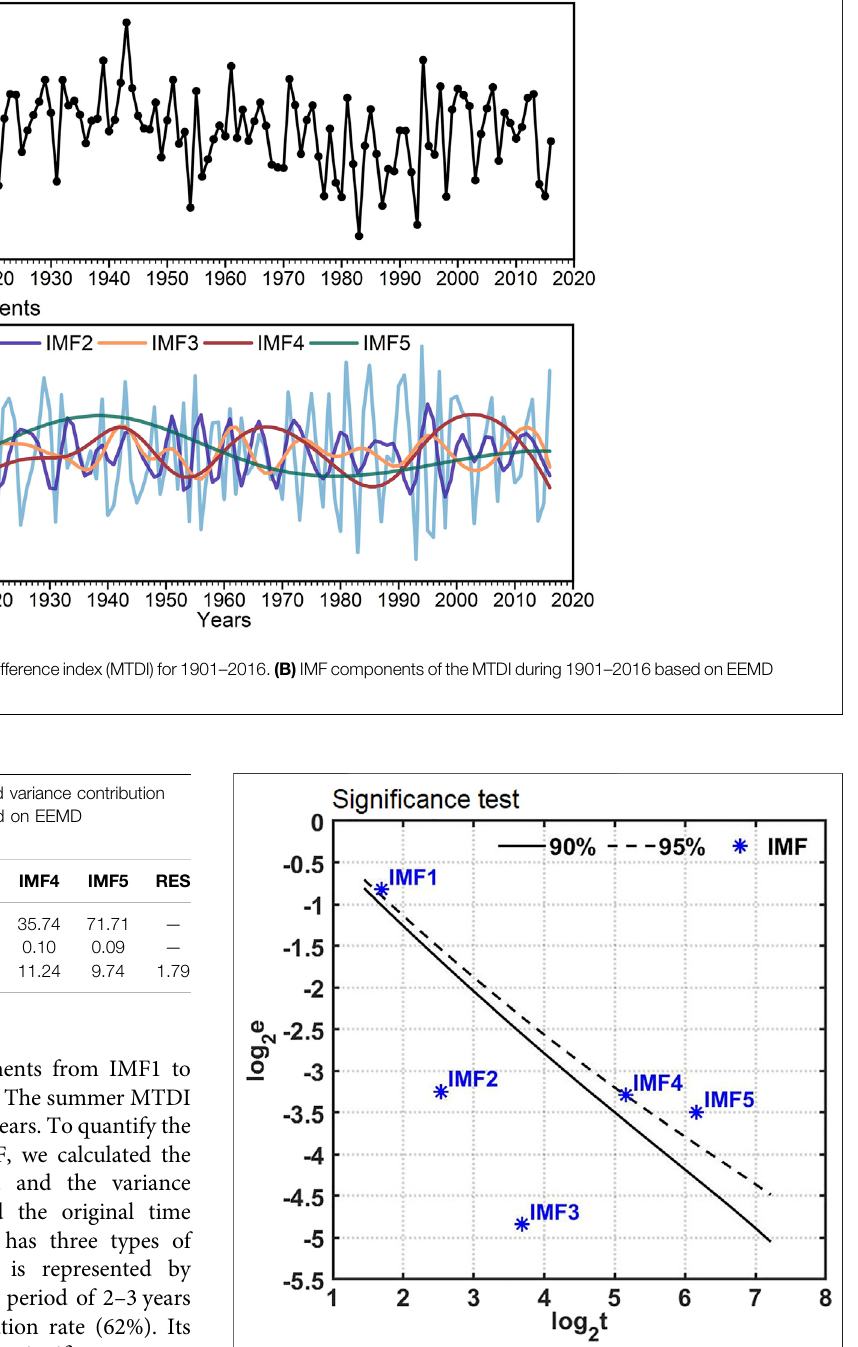
FIGURE 4 | The signi fi cance test of IMF components of the MTDI during 1901 – 2016 based on EEMD decomposition (e and t are normalized power spectral energy and average period,